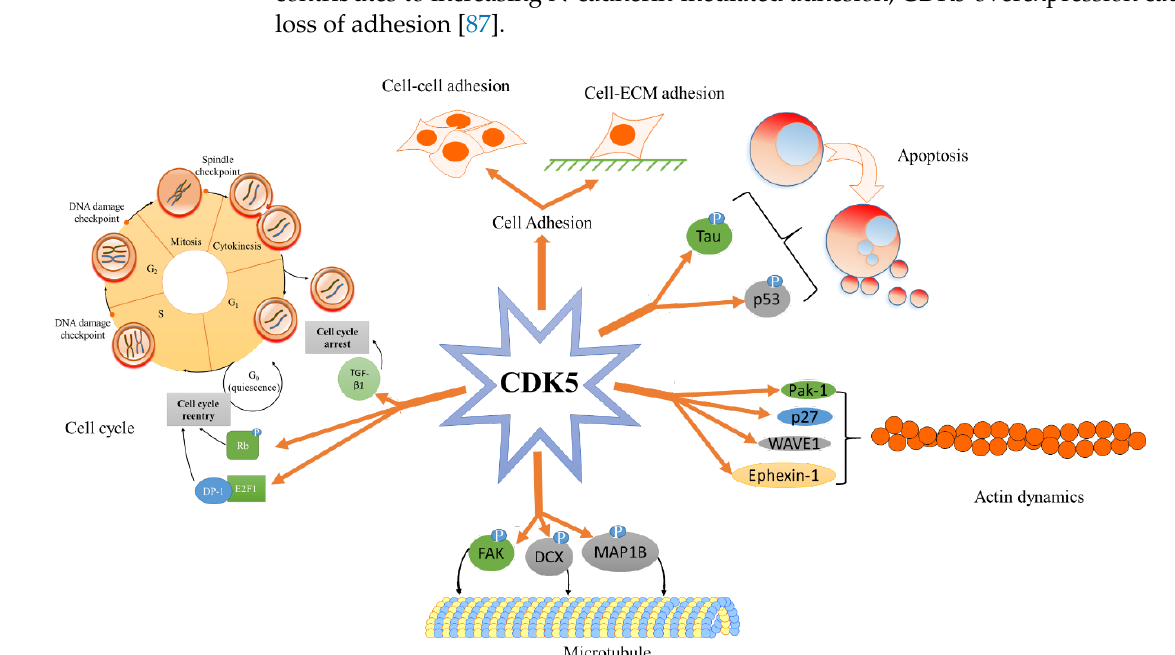
Figure 3. A summary of the various cyclin-dependent kinase 5 (CDK5)-mediated biological processes. CDK5 plays important roles not only in the central nervous system but also in different biological processes. Functions in the central nervous system include synaptic function, axon guidance, cell adhesion, and neurodegenerative diseases. Functions outside of the central nervous system include androgen production, cell cycle, cancer cell proliferation/apoptosis, and tumour metastasis. Abbreviations- microtubule-associated proteins 1B (MAP1B), focal adhesion kinase (FAK), doublecortin (DCX), p21 activated kinase 1 (Pak-1), Wiskott-Aldrich syndrome protein-family verprolin homologous protein 1 (WAVE-1), Eph receptor A4 (EphA4), transforming growth factor- β1′ (TGF - β1), retinoblastoma (Rb), E2F transcription factor 1 (E2F1). (modified from Shupp et al.